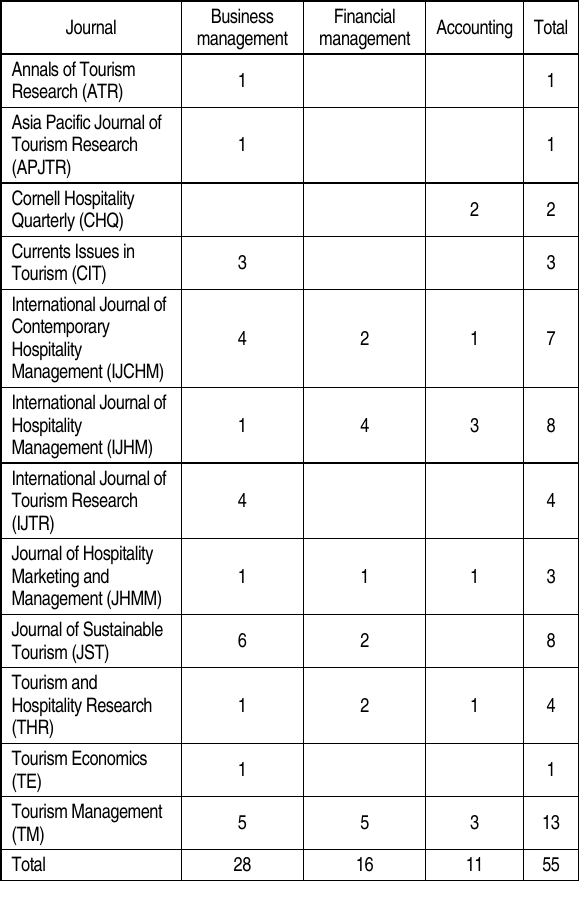
Table 1. Distribution of articles per topic